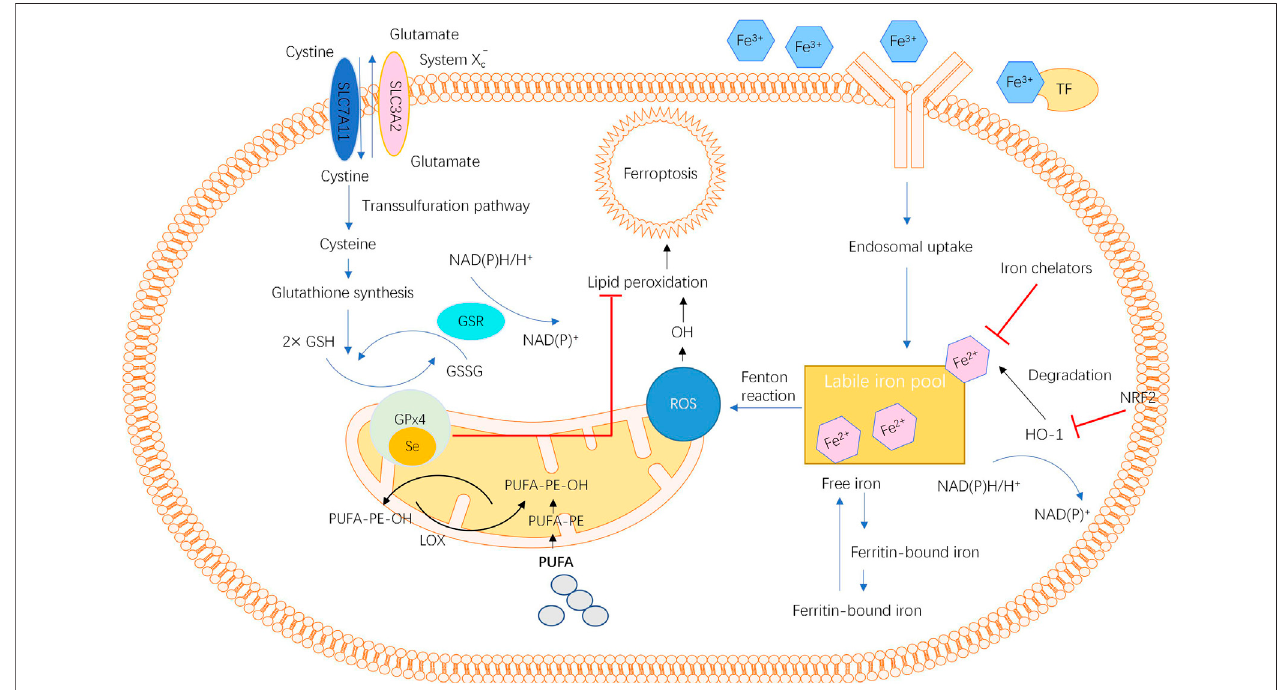
FIGURE 1 | The overall pathways and molecular mechanisms of